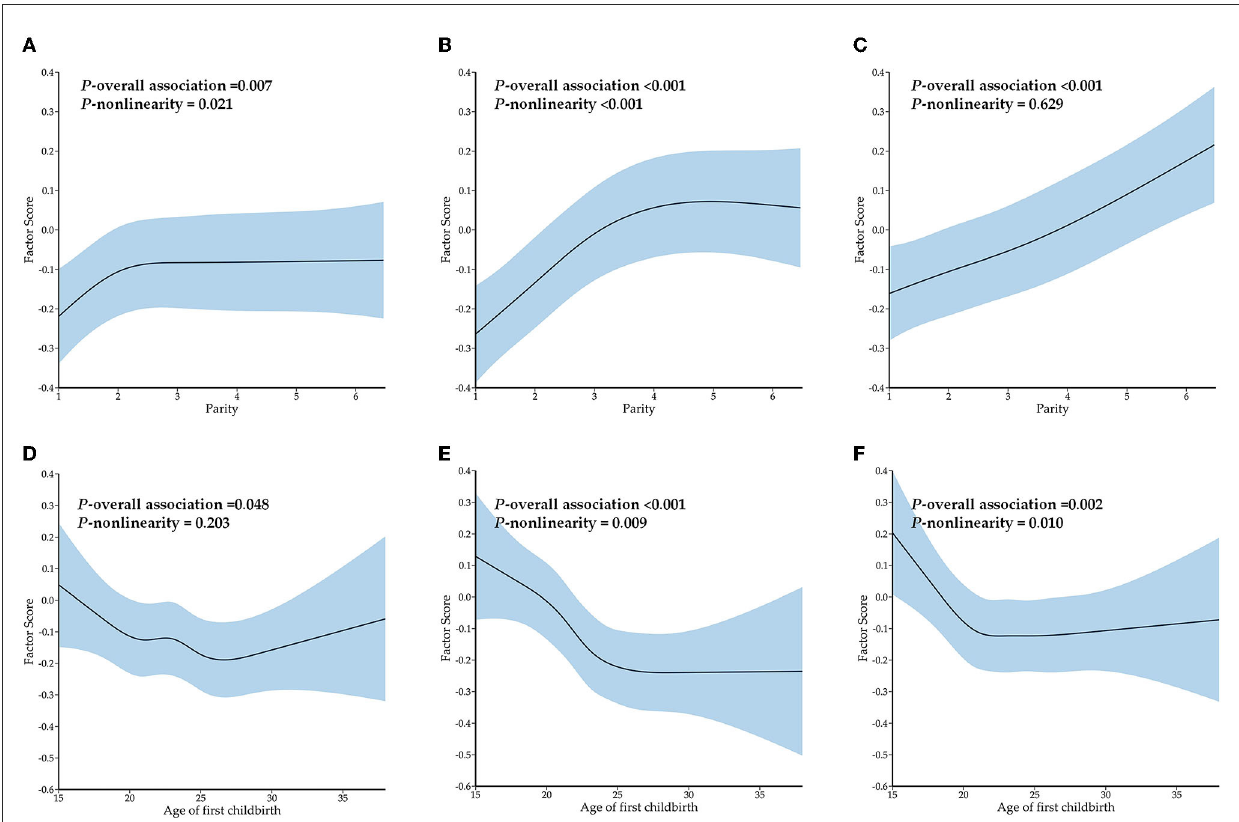
FIGURE6 The restrictive cubic splines on the association among parity, age of first childbirth, and factor scores of multimorbidity patterns. (A) Restrictive cubic splines on the association between parity and factor scores of the cardiac-metabolic pattern. (B) Restrictive cubic splines on the association between parity and factor scores of the visceral-arthritic pattern. (C) Restrictive cubic splines on the association between parity and factor scores of the respiratory-psychiatric pattern. (D) Restrictive cubic splines on the association between age of first childbirth and factor scores of the cardiac-metabolic pattern. (E) Restrictive cubic splines on the association between age of first childbirth and factor scores of the visceral-arthritic pattern. (F) Restrictive cubic splines on the association between age of first childbirth and factor scores of the respiratory-psychiatric pattern.